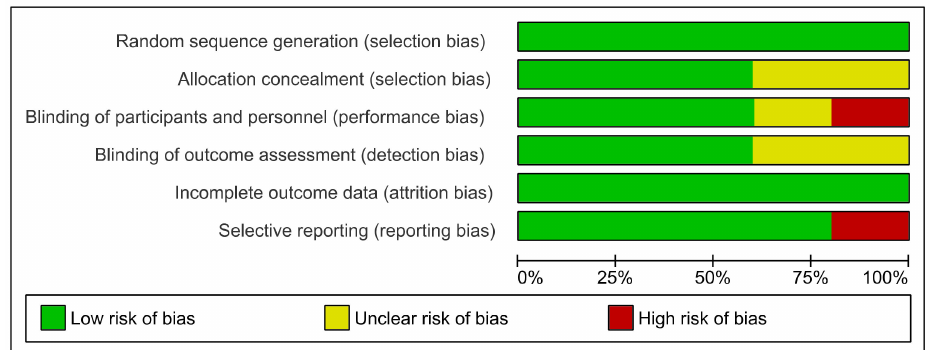
Figure 2. Summary of the risk of bias assessment according to the Cochrane risk-of-bias tool for randomized trials